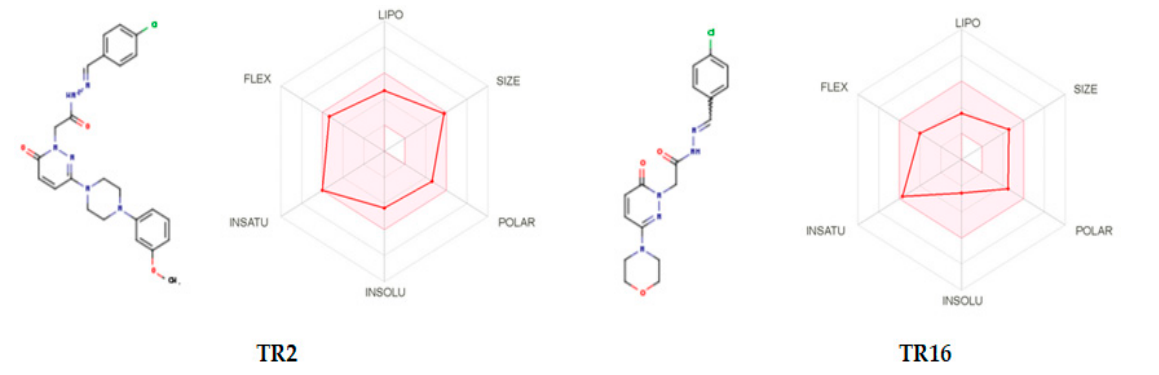
Figure 6. The bioavailability radar of TR2 and TR16 .